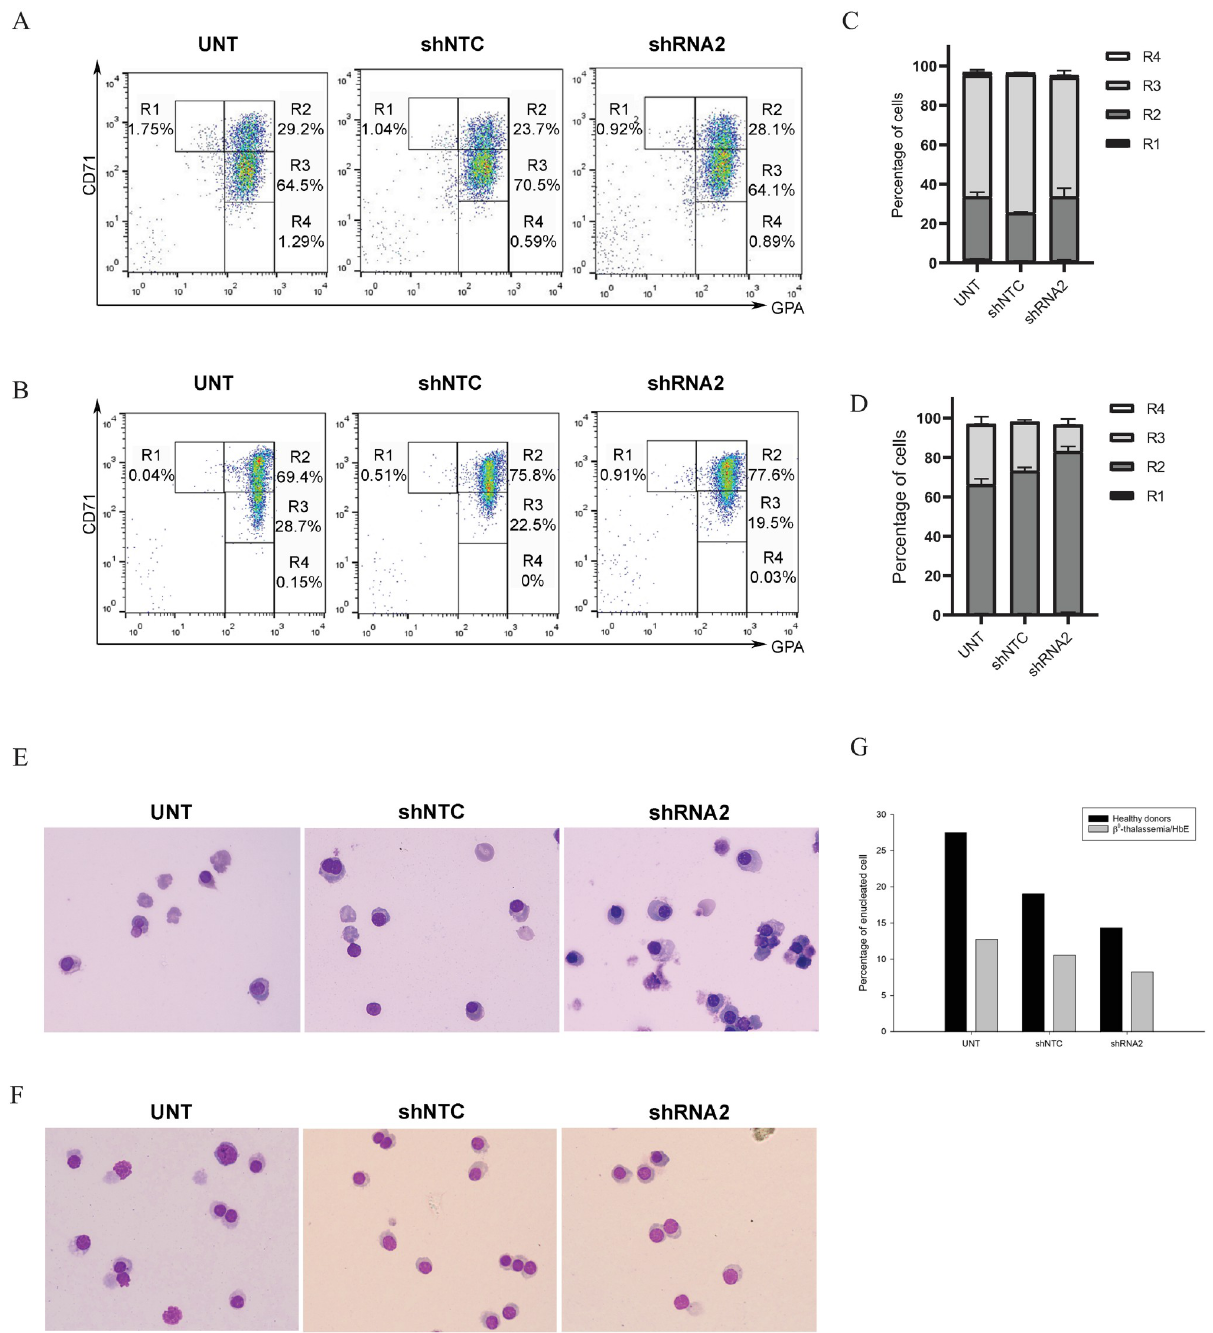
Fig 4. Flow cytometry analysis of erythroblasts on day 12 in different conditions. Representative picture of gated cell populations from early- to late- stage erythroblast (R1 to R4) with different levels of CD71 and GPA in healthy donors (A) and β 0 -thalassemia/HbE patients (B) were presented. Mean ± SEM of each cell population was displayed in the bar graph generating from 2 healthy donors (C) and 3 β 0 -thalassemia/HbE patients (D). Cell morphology of erythroid cells on day 12 stained with Wright-Giemsa dye: healthy donor (E); β 0 -thalassemia/HbE patient (F). The mean percentages of enucleated cells were shown as bar graph, data was collected from 2 healthy donors and 2 β 0 -thalassemia/HbE patients (G).